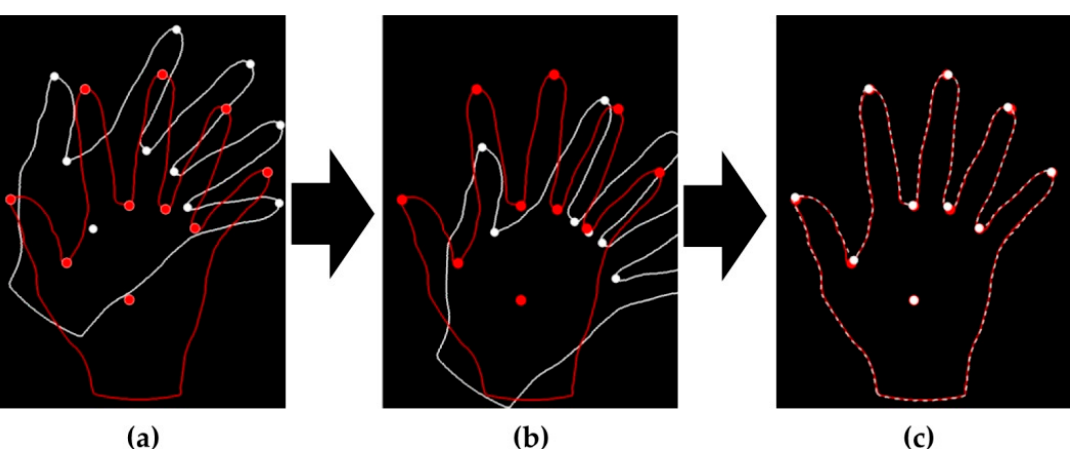
Figure 19. Image registration of the inquiry hand contour (white) against the reference hand contour (red): ( a ) the inquiry hand contour and the reference hand contour; ( b ) registering both hand contour by affine transformation; ( c ) the result of image registration.